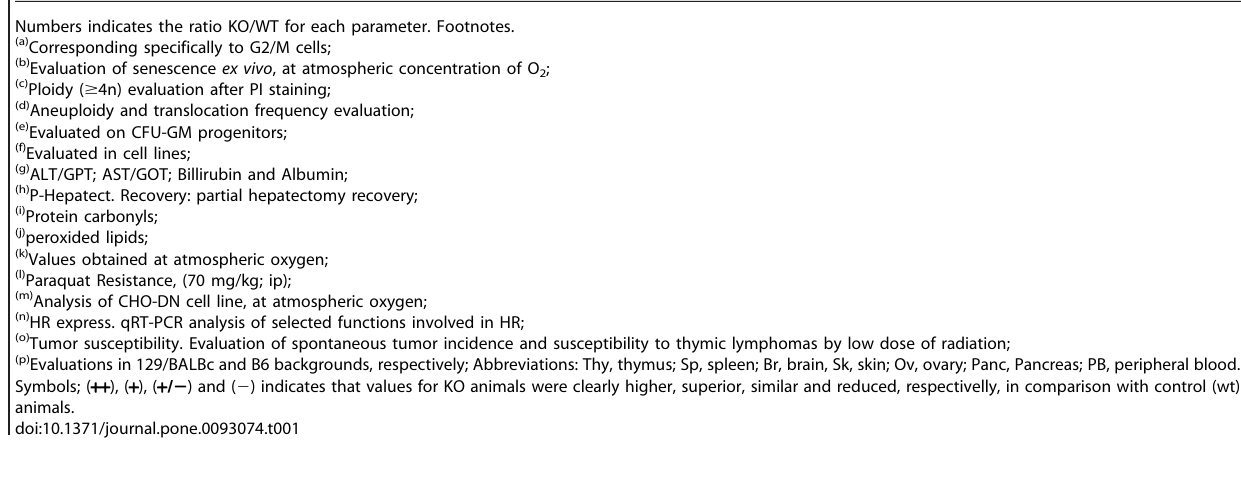
Liver BM Heart Other organs Global MEFs Other Cell Cycle x 2 (a) x